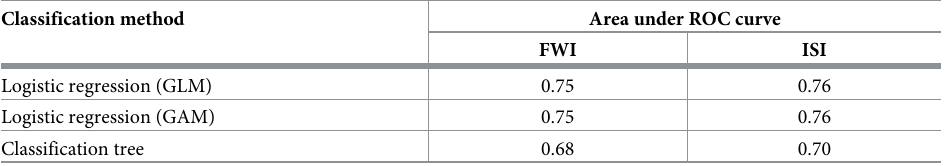
Table 3. Comparative performance of alternate classifiers on the test data. These models all classified fires into two groups according as at BH was reportedly greater than, or equal to, size at